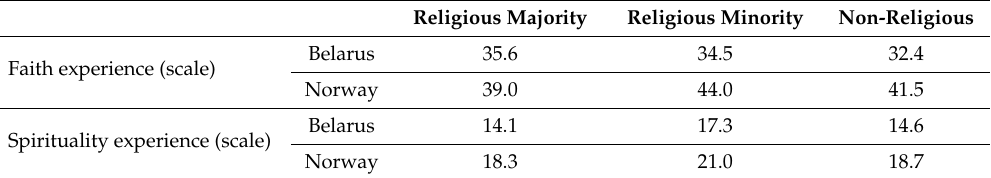
Table 4. Percentage of respondents who had faith / spirituality experiences (frequencies